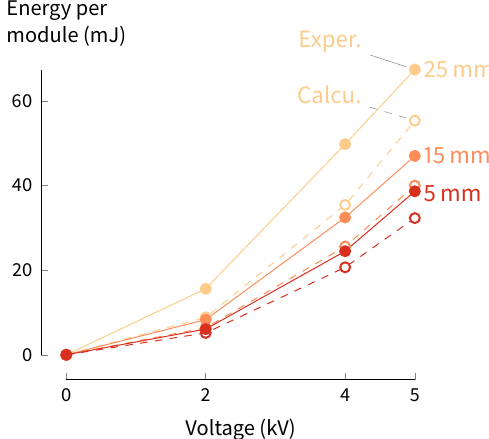
Figure 11. Much of the electrical energy used to charge the DET modules was stored in the modules and could be recovered to increase the efficiency of stiffness changing. These values are the energy used to change stiffness during relaxation tests. The stored energy values calculated from Equation (1) are marked with hollow markers connected by dashed lines, and experimental values are shown with circular markers connected by solid lines.